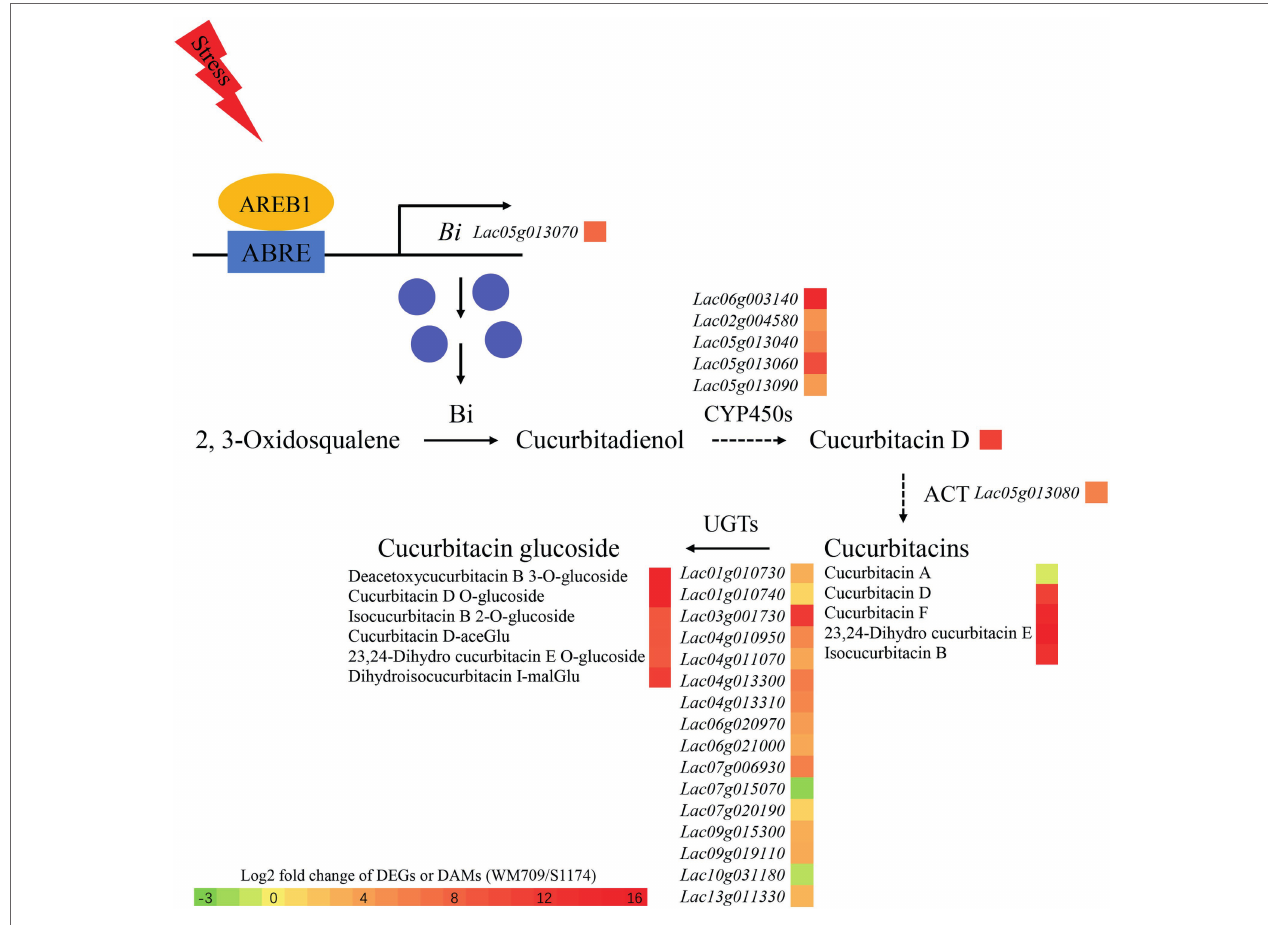
FIGURE 6 | Regulatory network of predicted cucurbitacin biosynthesis. CYP450s, cytochromes P450s; ACT, acyltransferase; and UGTs, UDP- Glucosyltransferases. Green boxes indicate down-regulated transcripts and metabolites, red boxes indicate up-regulated transcripts and